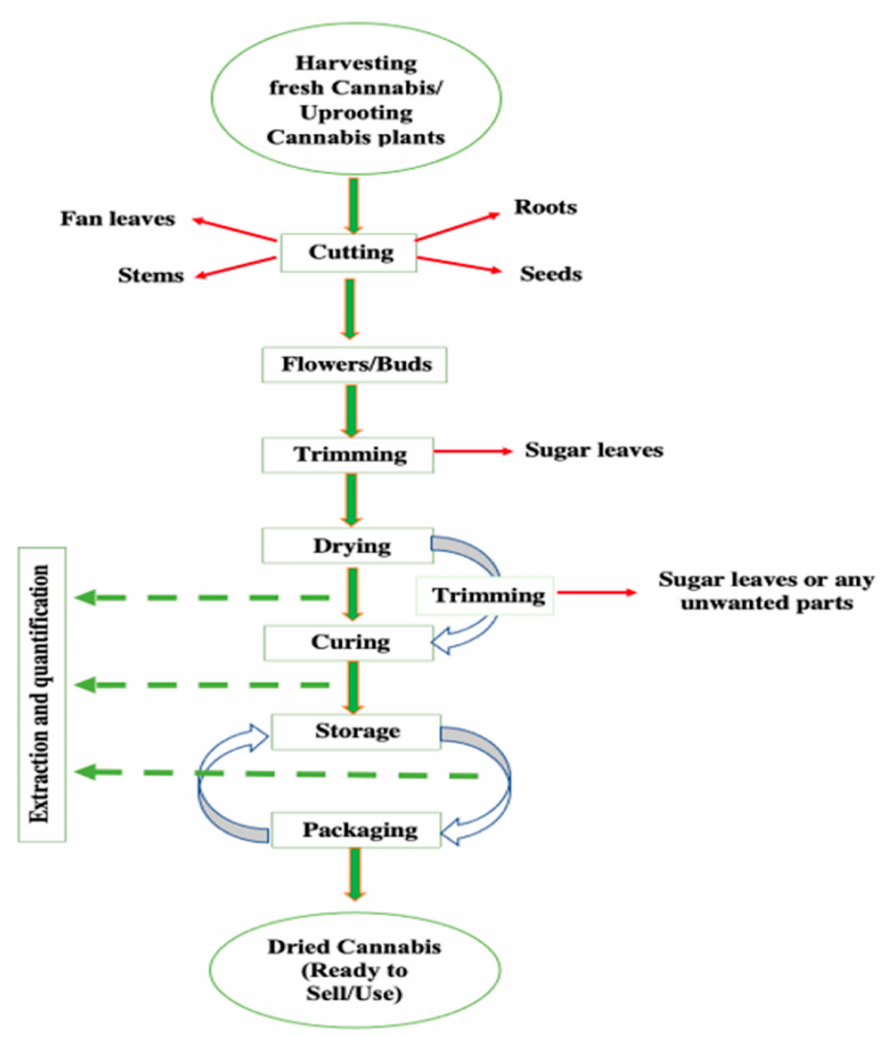
Figure 3. Postharvest operations involved in cannabis